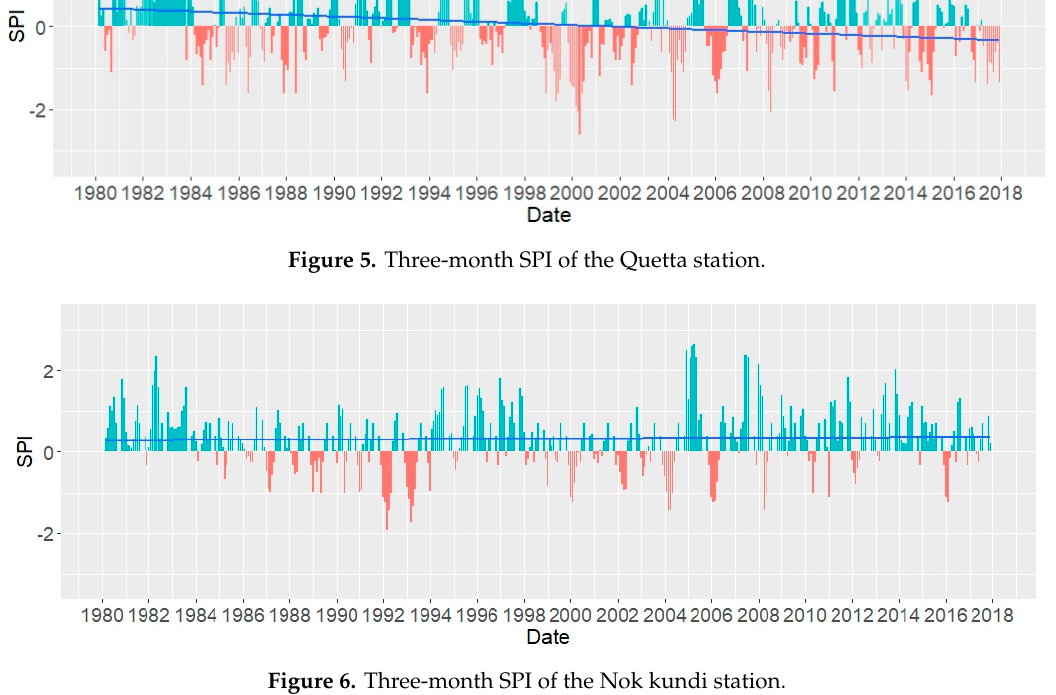
Figure 6. Three-month SPI of the Nok kundi station.